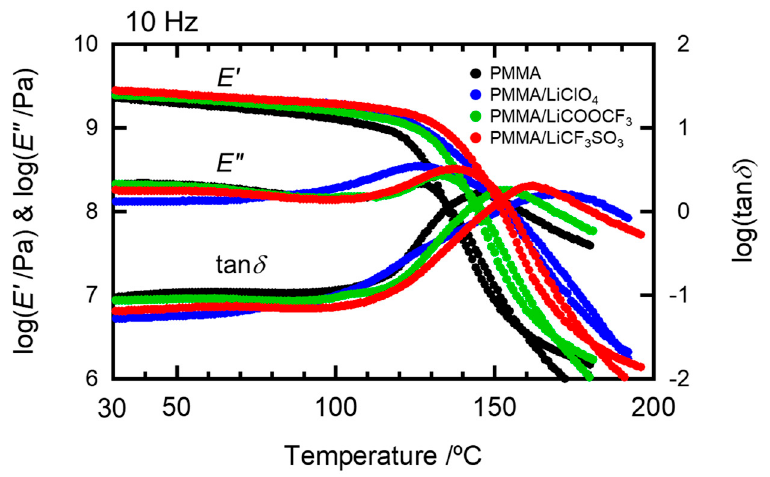
Figure 1. The dynamic mechanical properties of the prepared PMMA/salt samples with [Li]/[C=O] = 0.07.